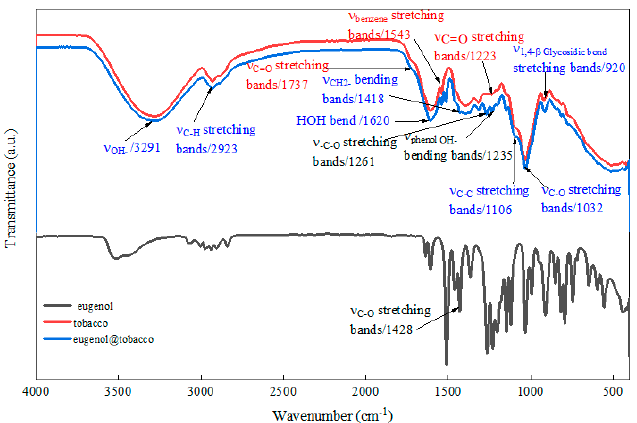
Figure 2. FTIR spectra of eugenol, tobacco leaf and tobacco leaf loaded with eugenol.